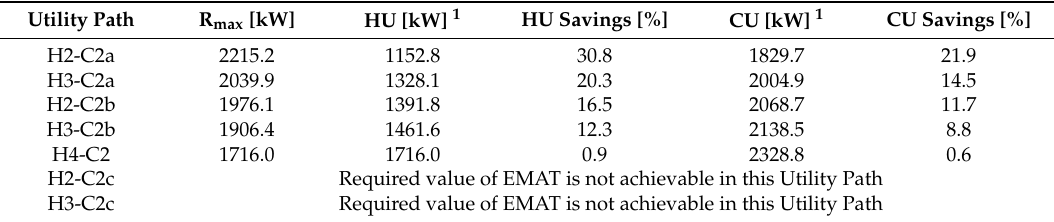
Table 2. Retrofit Identification Table (RIT) of the studied process.